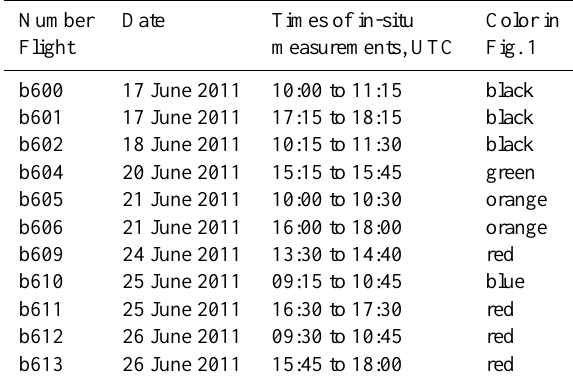
Fig. 1. Map showing locations of in-situ measurements and dust source regions. Straight lines show locations of in-situ straight and level runs (horizontal legs) used in this study. Circles indicate likely source areas of the dust sampled during the flights. Pink star indi- cates the location of Fuerteventura, Canary Islands, Spain, where the FAAM aircraft was based. Different colors correspond to the event categories described in Sect. 5 and Fig. 11. Horizontal legs in grey are not included in Fig. 11.